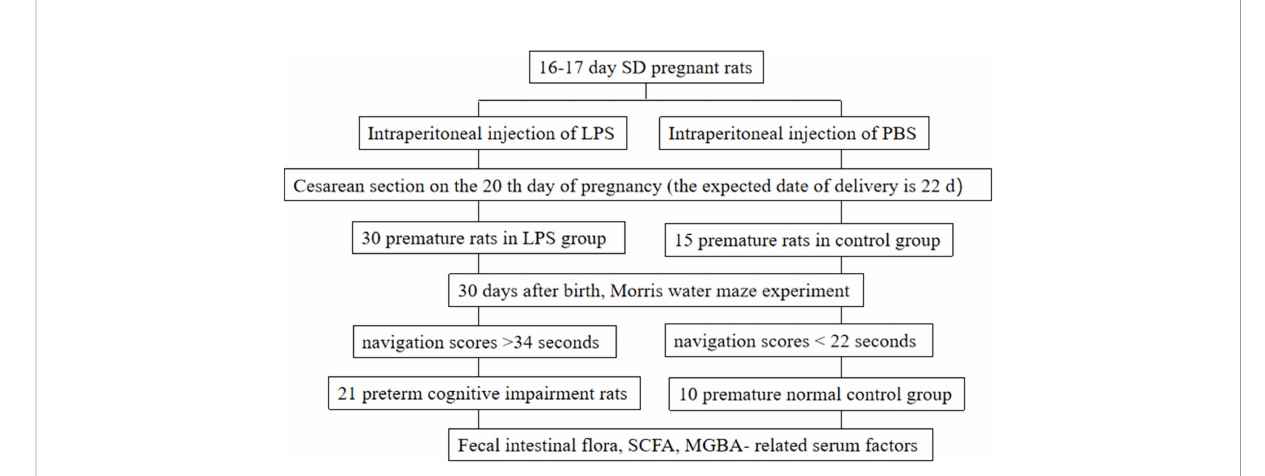
FIGURE 1 Experimental fl ow chart of the rat groups assignment to describe the experimental